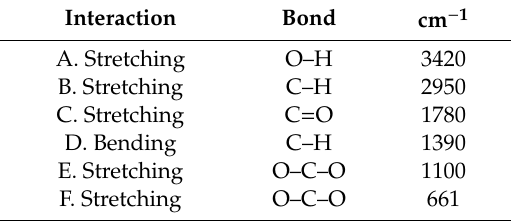
( b ) Figure 6. Cyclic carbonates results: ( a ) TGA curve and ( b ) DTG thermograph. The next degradation step takes place in the range of 123 – 173 °C at a weight loss of 20.37%, possibly due to the loss of solvent and corresponding to an endothermic peak at 149.19 °C. A third degradation step has a maximum weight loss of 2.69% in the range of 173 – 700 °C, assigned to the decomposition of the cyclic carbonates and is associated with endothermic peaks at 482.15 and 521.20